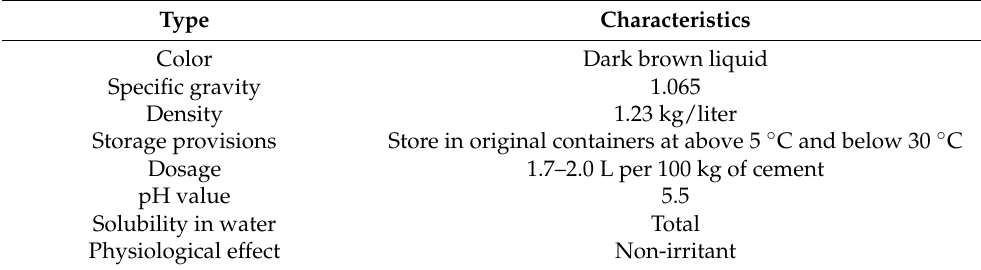
Table 4. The basic characteristics of Glenium 110M